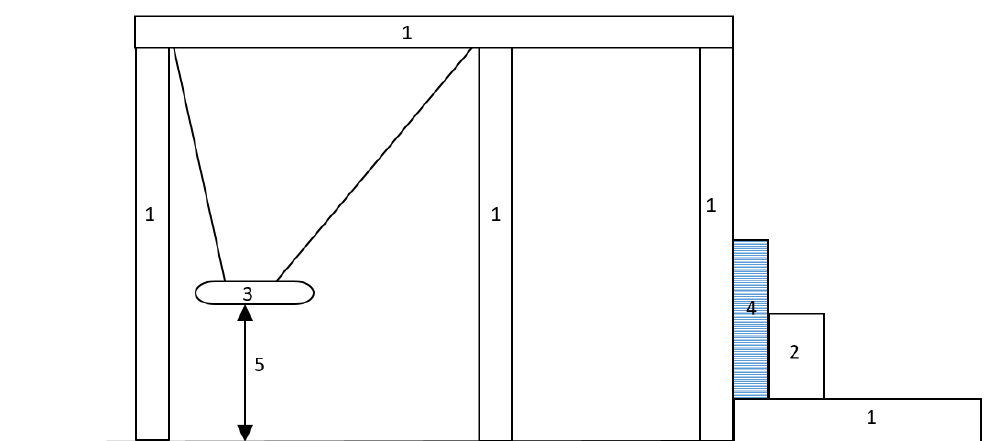
Figure 5. Pendulum diagram: 1—pendulum, 2—stabilizing weight, 3—drop weight, 4—specimen, 5—height.